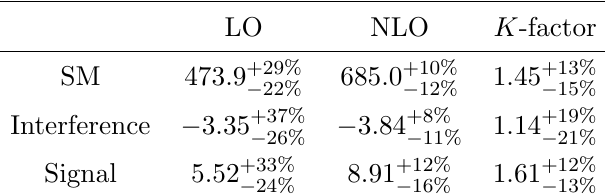
Table 6 . Cross sections for benchmark C2 in pb. Uncertainties are from renormalisation and factorisation scale variation.